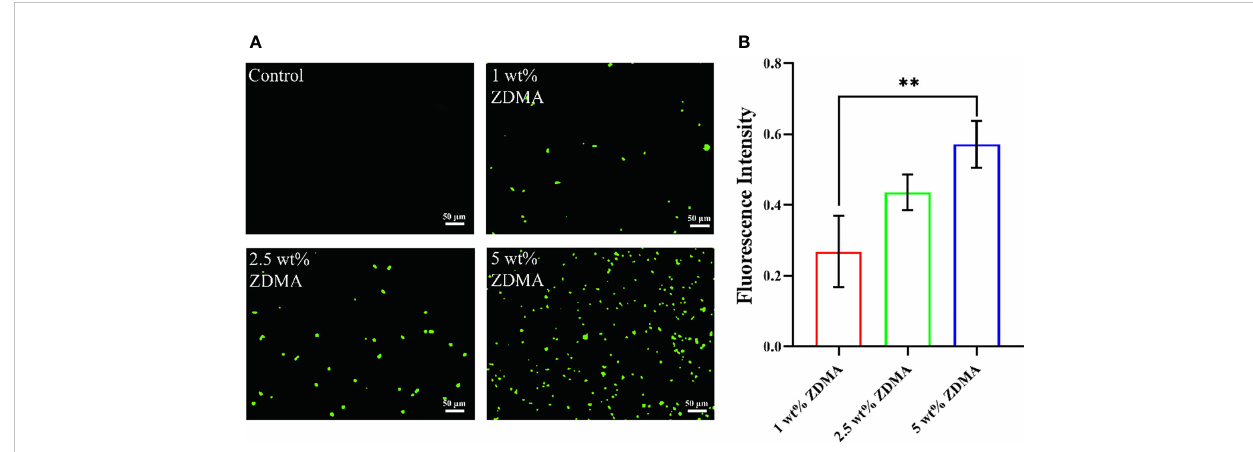
FIGURE 10 The expression of intracellular ROS in C. albicans . (A) Representative ROS fl uorescence staining images from each group. (B) Means ± standard deviations for fl uorescence intensity of each group (**p <